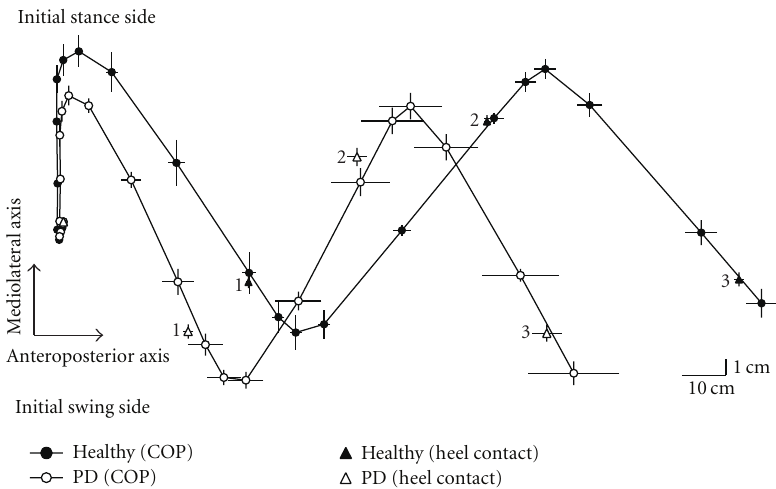
Figure 2: Averaged COP trajectory and heel contact position between the onset of COP displacement and the 4th toe o ff . Circles indicate the average of the normalized COPs. Triangles indicate the average of the normalized heel contact positions. Data points indicate the mean, and error bars indicate standard errors of the mean.